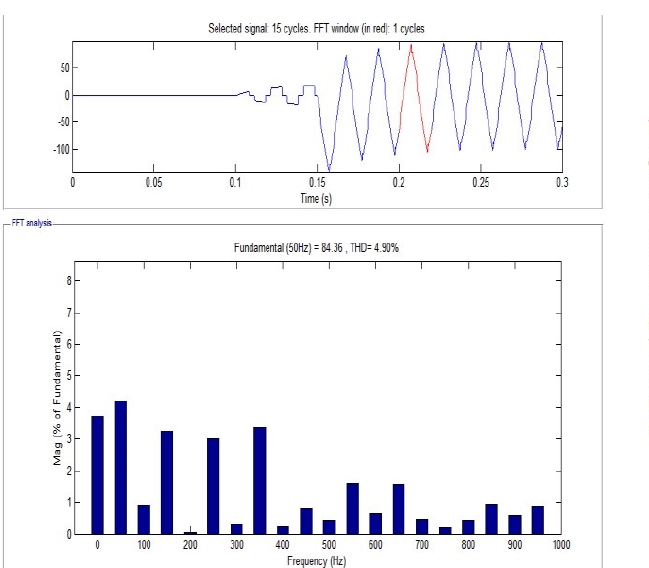
Figure 15. Active and Reactive Power of Grid